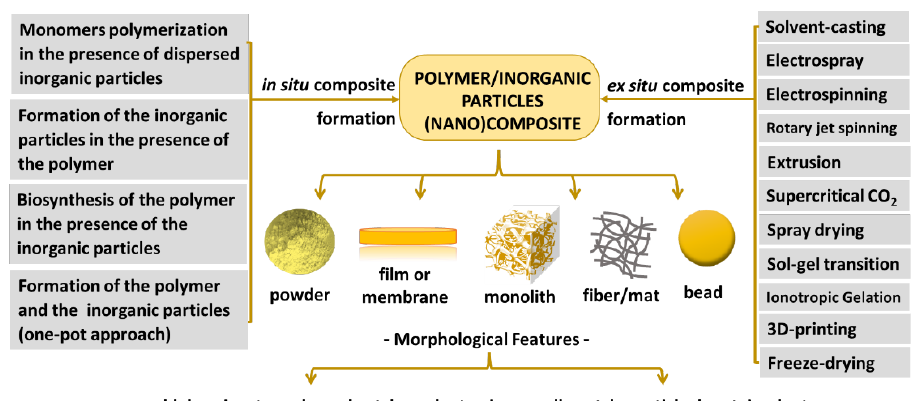
Figure 5. Experimental approaches to produce nanocomposites based on organic polymer and inorganic nanofillers: in situ methods (left side) and ex situ methods (right side).